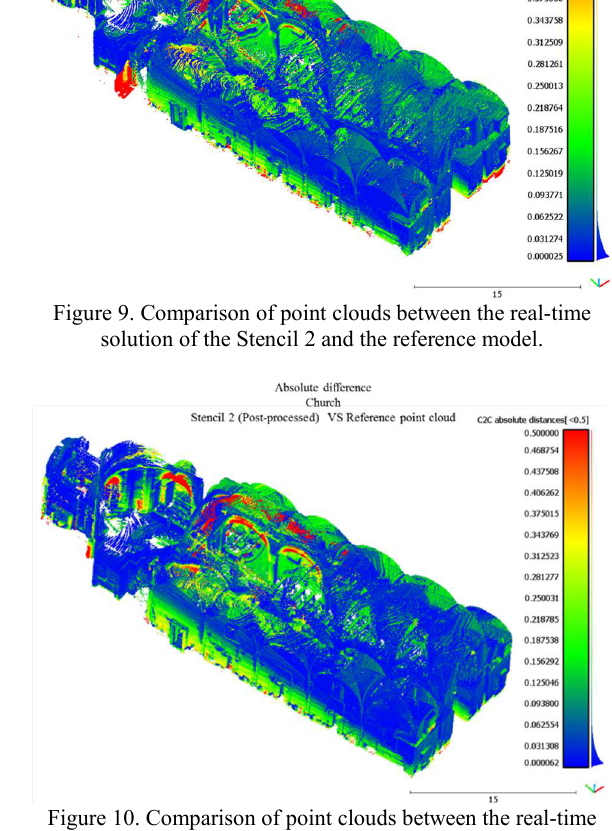
Table 3. Acquisition configuration parameters set for data reprocessing.